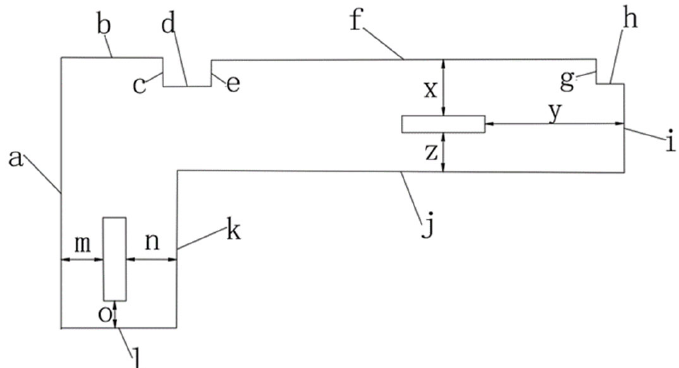
Figure 27. Schematic figure of actual scene.